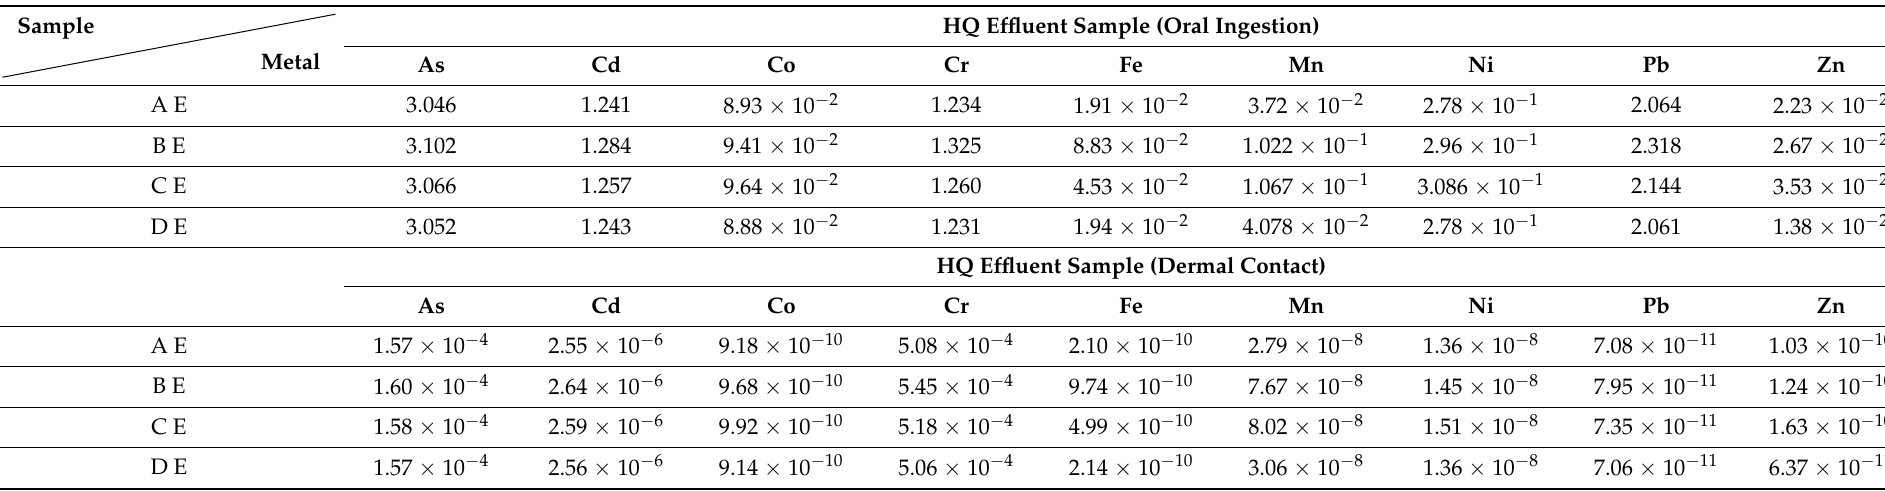
Table 1. Hazard quotient (HQ) for oral ingestion and dermal adsorption for the selected heavy metals in the effluent samples. Sample